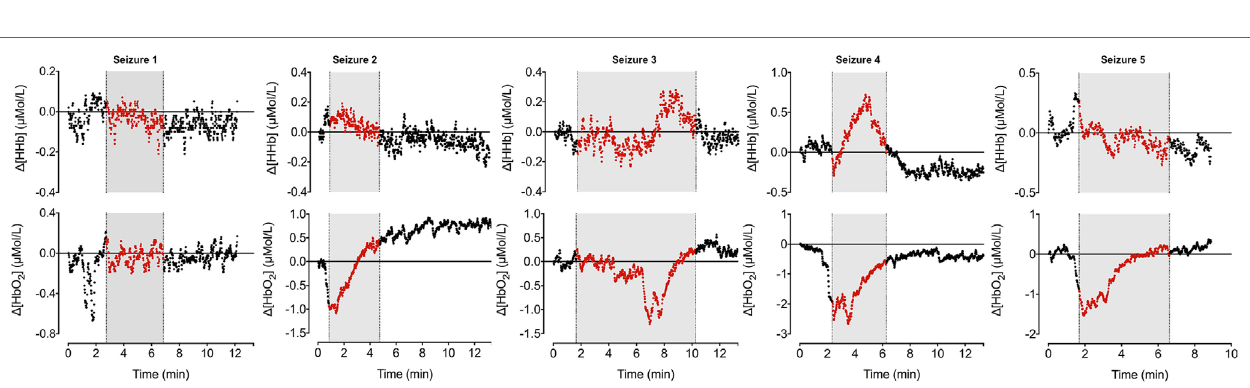
FIGURe 4 | Changes in oxy- and deoxy hemoglobin ([Hbo 2 ] and [HHb]) during seizures . [HHb] increases and decreases during ictal period while [HbO 2 ] follows opposite trend.